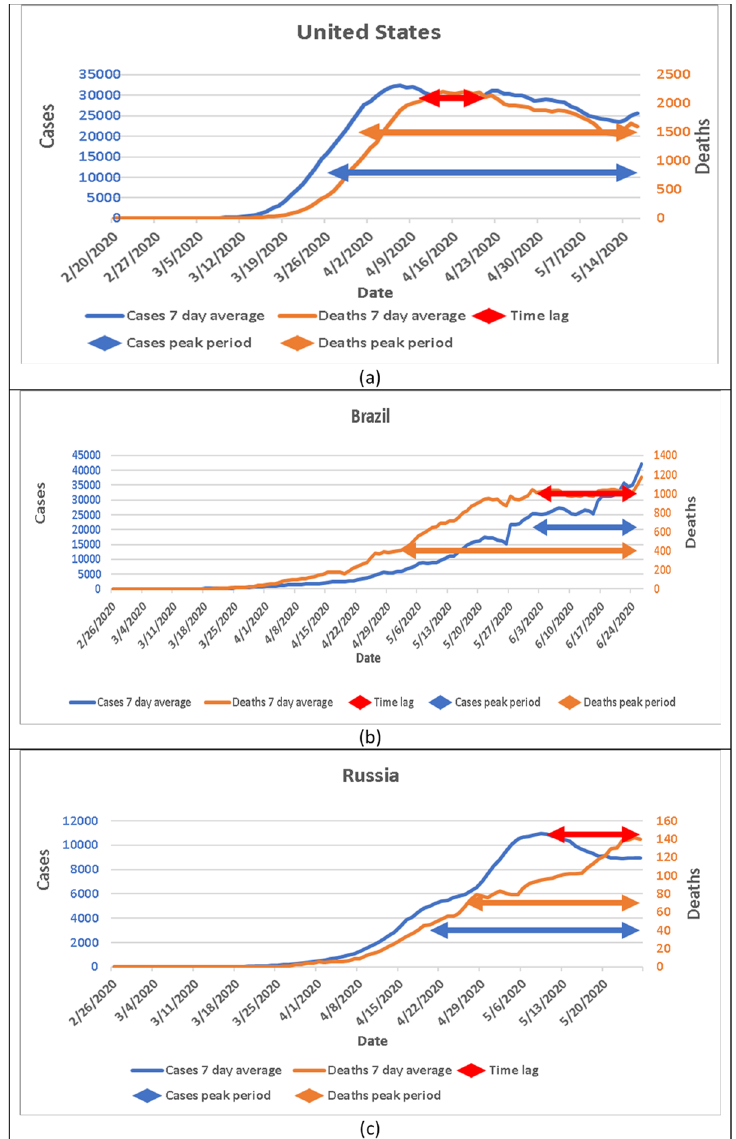
Figure 3. Patterns of death in three different countries with persistently high numbers of COVID-19 cases. ( a ) New cases and new deaths in the United States; ( b ) New cases and new deaths in Brazil; ( c ) New cases and new deaths in Russia.